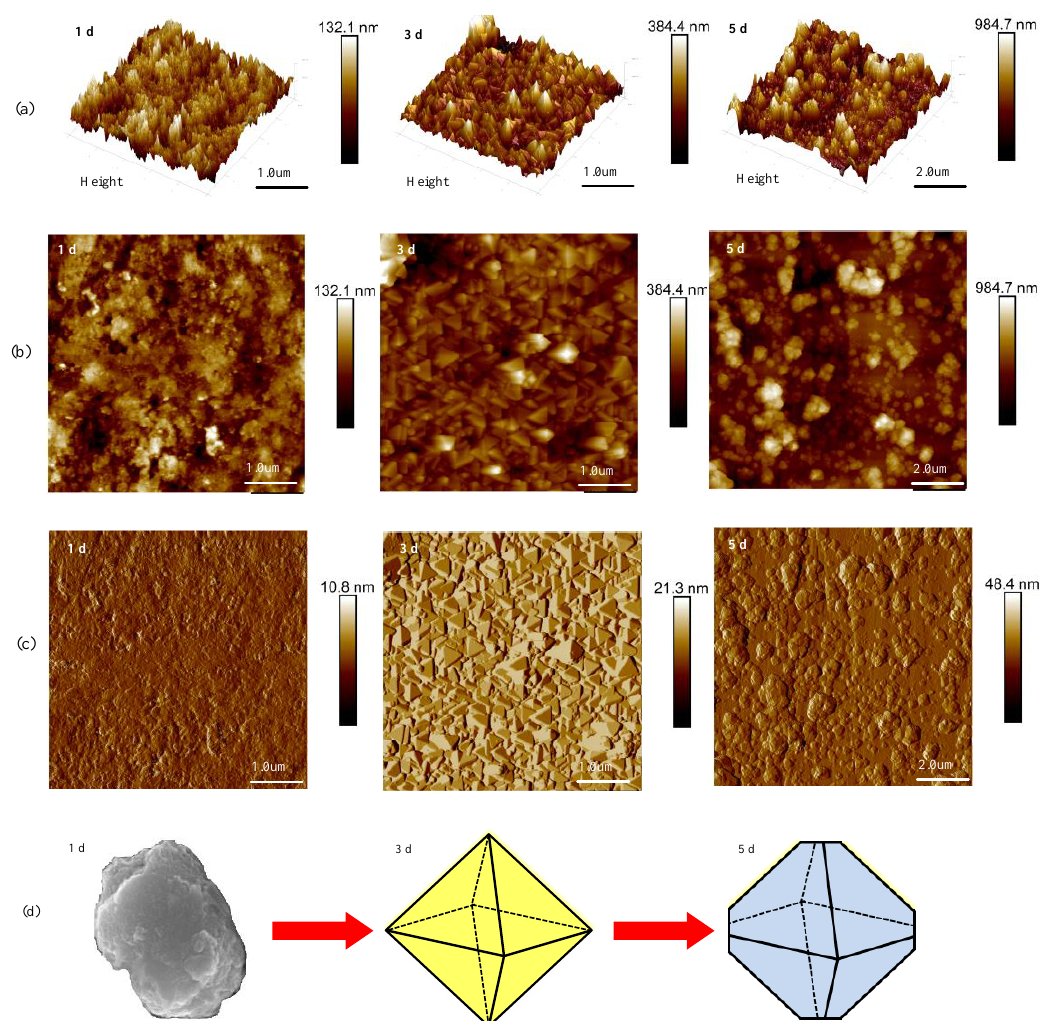
Figure 5. AFM images ( a – c ) and schematic ( d ) of the corrosion products on the Q235 steel surface with different corrosion times.